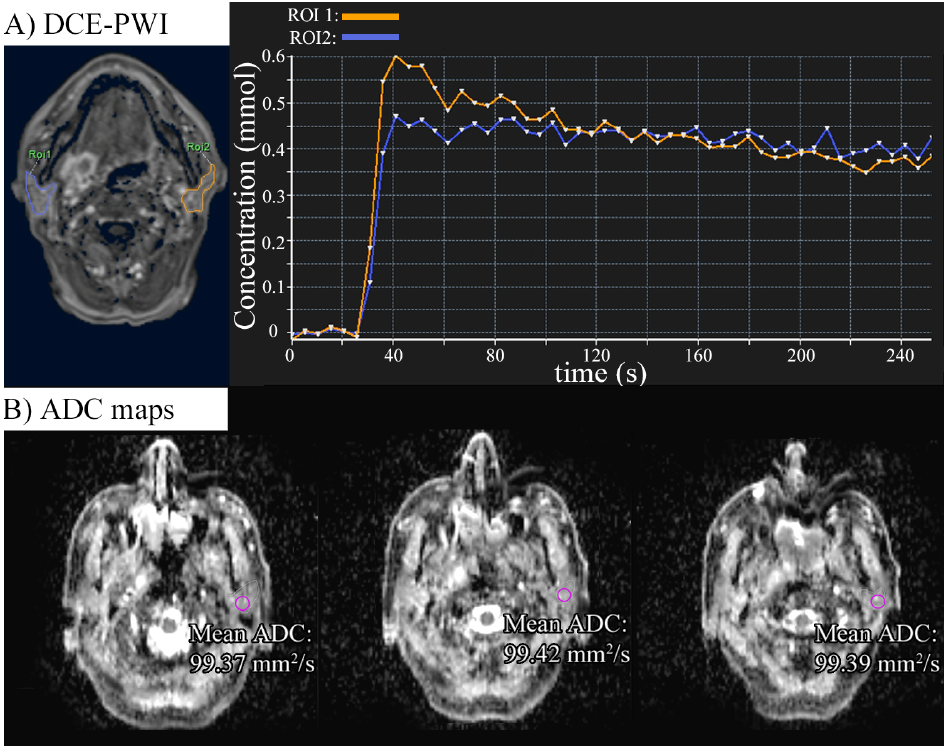
Figure 2. Region of interest (ROI) definition for functional MRI. ( A ) DCE ‐ PWI ROI definition for kinetic parameters drawn on both the parotid glands. The graph shows the contrast agent concentration over time for the two ROIs (left and right parotid gland, respectively). ( B ) ADC map ROI definition for local ADC values (see purple circle ROIs on the left parotid gland) with mean ADC values.